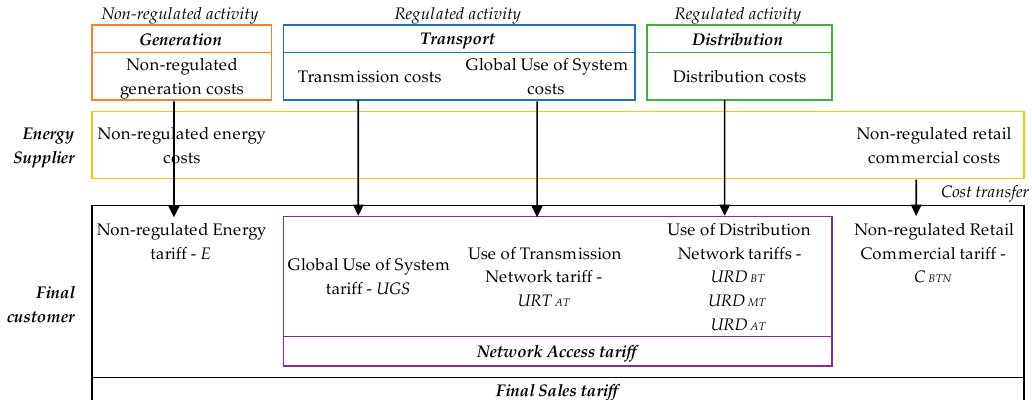
Figure 2. Components of the final sales tariff presented to final customers in the liberalised Portuguese energy market. Source: Adapted from Energy Services Regulatory Authority [26].